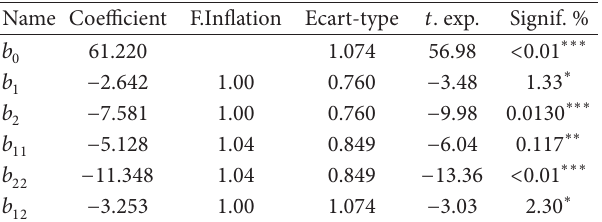
T 3: Analysis of variance of the activated carbon yield, R/AC-H